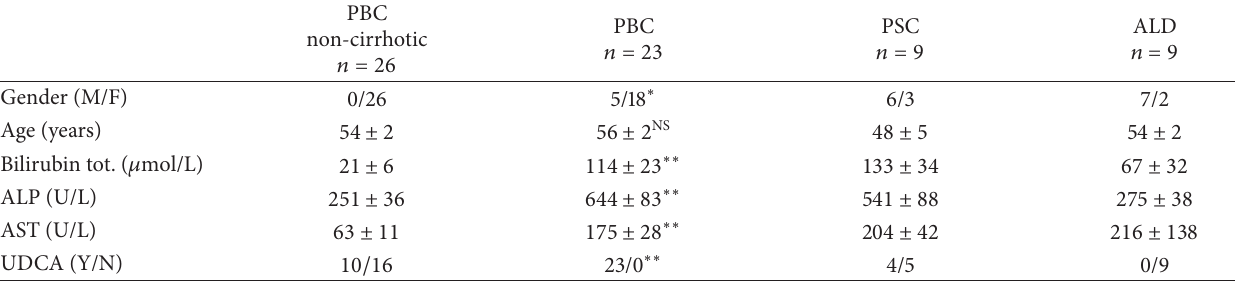
Table 1: Clinical and laboratory data on analyzed patients. 𝑃 values between non-cirrhotic and cirrhotic patients with PBC. PBC